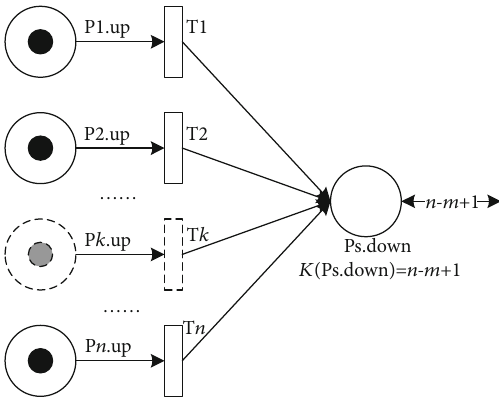
Figure 1: The model of the static